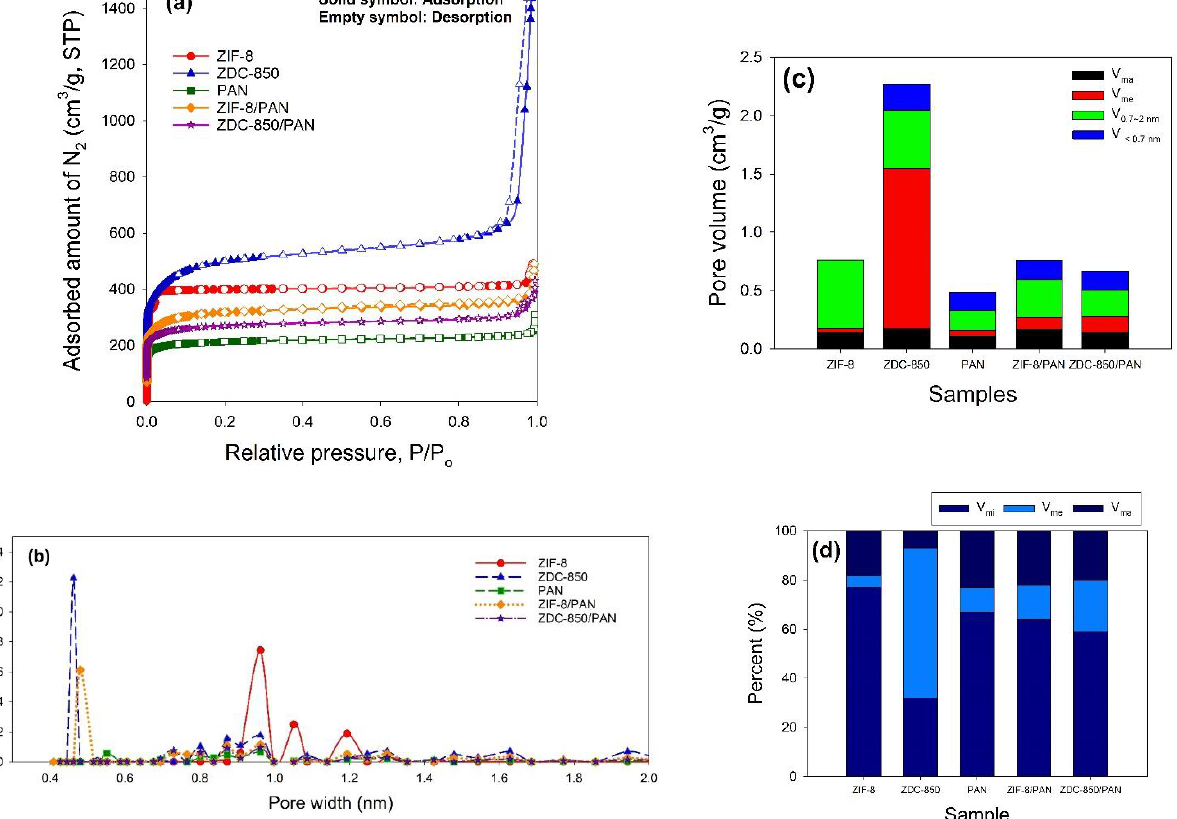
Figure 4. Adsorption–desorption measurements of N 2 for the samples at −196 °C: ( a ) isotherms; ( b ) pore size distributions of the samples, which were derived using NLDFT model; ( c ) distributions of different pore volumes; ( d ) percent of pore volumes.